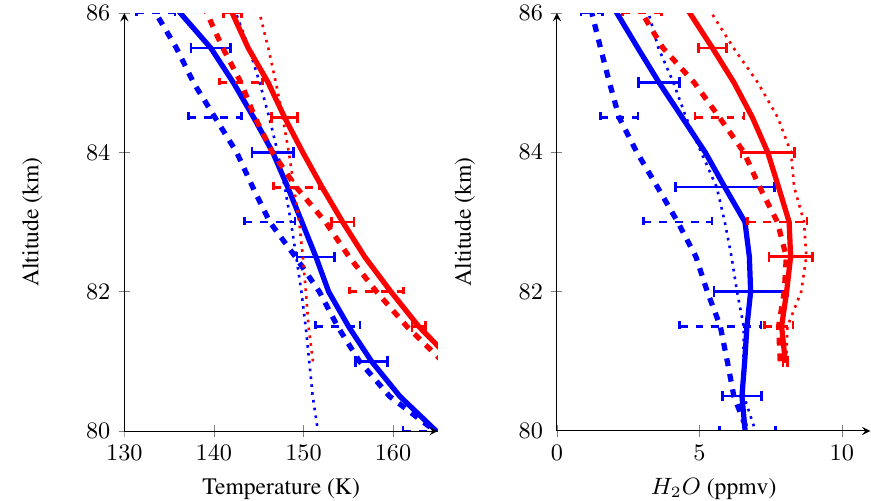
Figure 1. The figure shows differences in the measured background temperature and water vapour concentration for cloud (dashed lines) and cloud-free pixels (solid lines) for July (blue) and August (red). The values are calculated by adding the measured mean profile for latitudes > 70 ◦ N to the mean anomalies from these latitudes (for further description see the text). The thin horizontal lines are the standard deviation for the plotted quantities. The thin dotted lines show the mean frost point temperature (left figure) and total water content for cloudy pixels ( Q tot = Q gas + Q ice ) (right